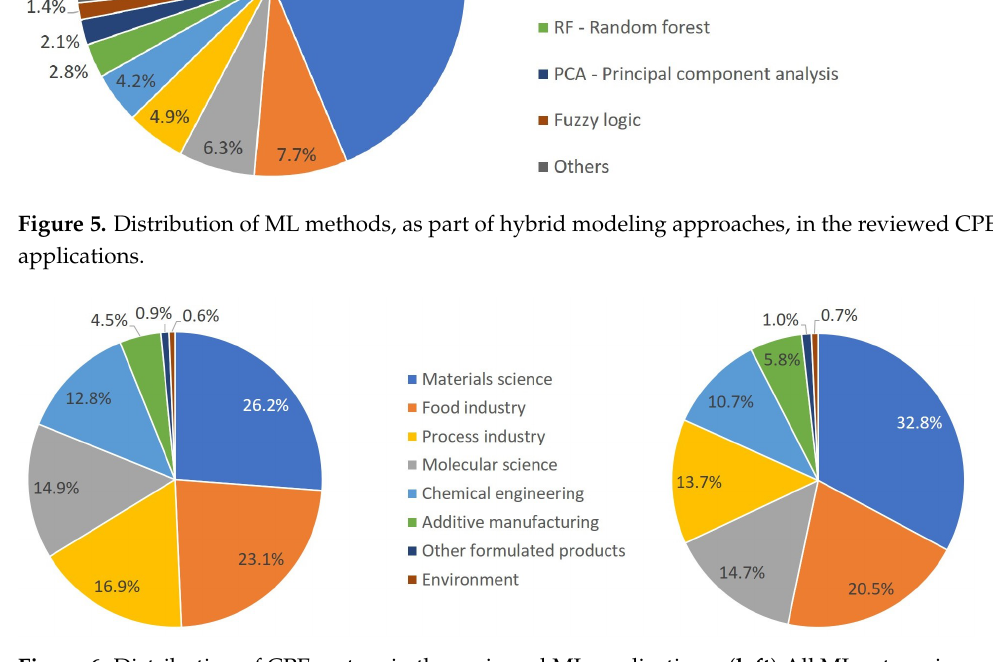
Figure 6. Distribution of CPE sectors in the reviewed ML applications. ( left ) All ML categories are considered. ( right ) Only supervised learning is